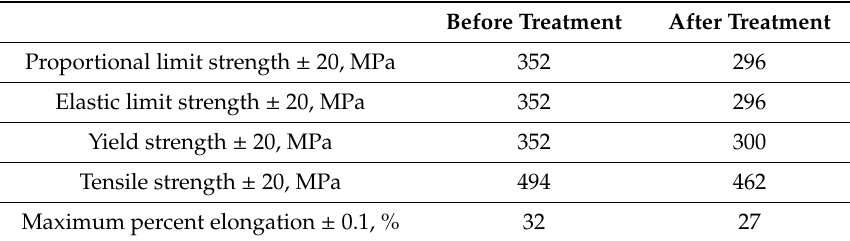
Table 8. Main parameters of steel specimens in di ff erent states.